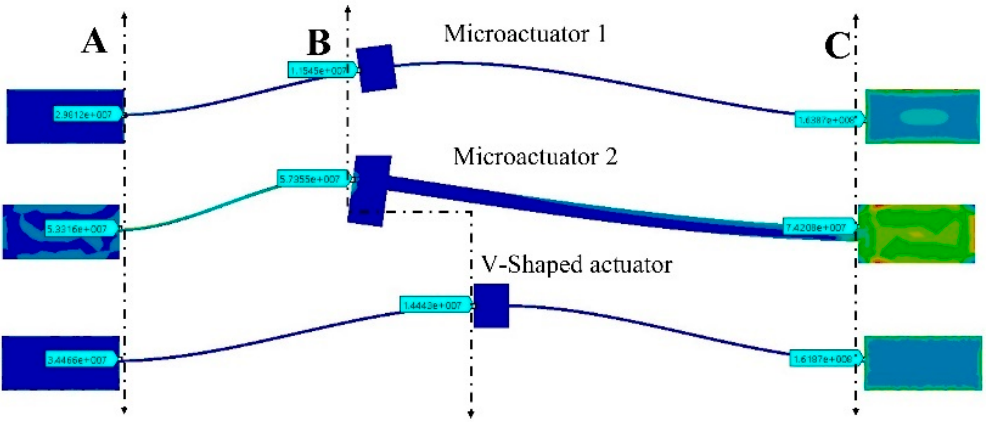
Figure 9. Results of equivalent von Mises stress for the microactuators considered. A represents the